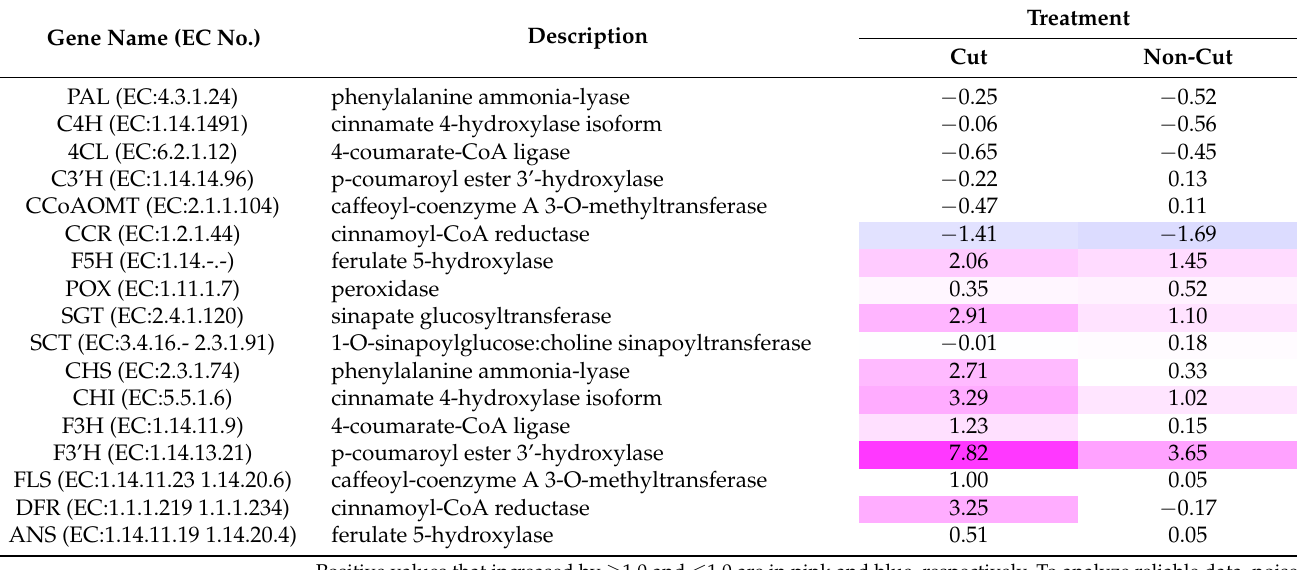
Table 1. Gene expression variation related to phenylpropanoid and flavonoid biosynthesis in canola subjected to UV irradiation with or without 300 nm short-cut filters. Values indicate Log2 ratios ( n = 1) obtained by calculating treatment: control gene expression ratios. The UV-B irradiation intensity at the top of the cultivation panel was set to 0.6 W m − 2 .